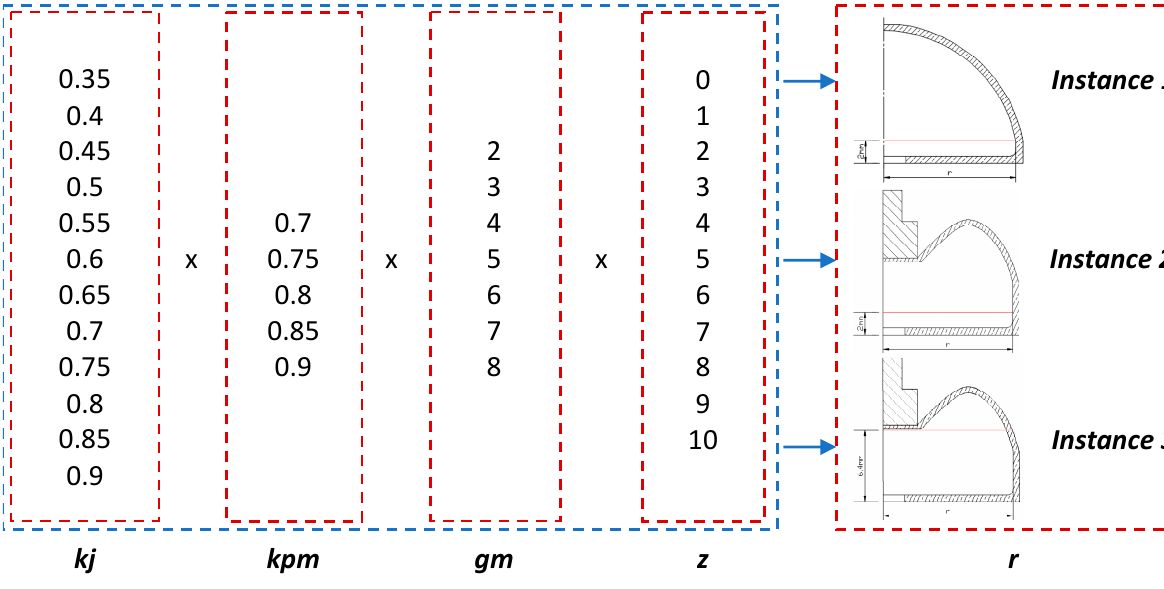
Figure 8. The configuration matrix of optimisation study setups including kj , kpm , gm geometry parameters, and z -distance scenarios. Three instances were studied.